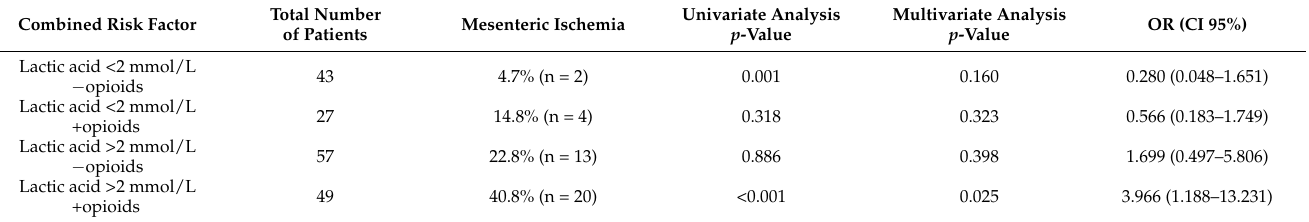
Table 4. Univariate and multivariate analysis of the combined risk factor for mesenteric ischemia: lactic acid elevation and opioid infusion.